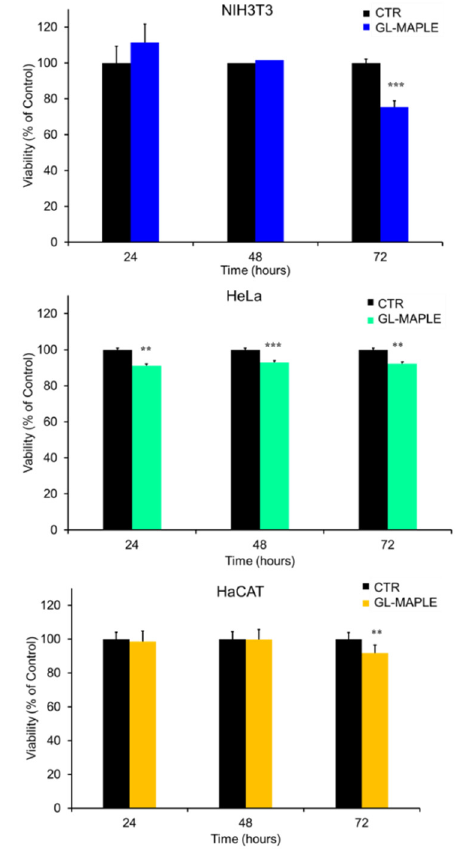
Figure 8. Cell viability measurement by MTT assay on NH3T3 (( upper ) panel), HaCAT (( central ) panel) and HeLa (( lower ) panel) cell lines placed at direct contact with GL-MAPLE slices for the indicated time. Values are expressed as mean ± SD ( n = 6). Asterisks denote significant differences at p < 0.05 (*), p > 0.01 < 0.05 (**) and p < 0.01 (***).